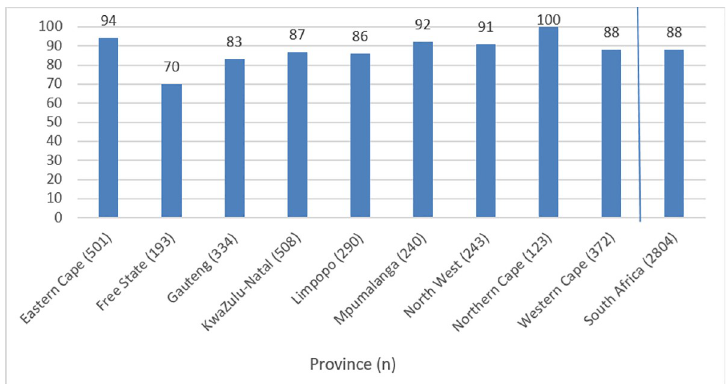
Fig 2. Percentage of facilities responding to survey by province and